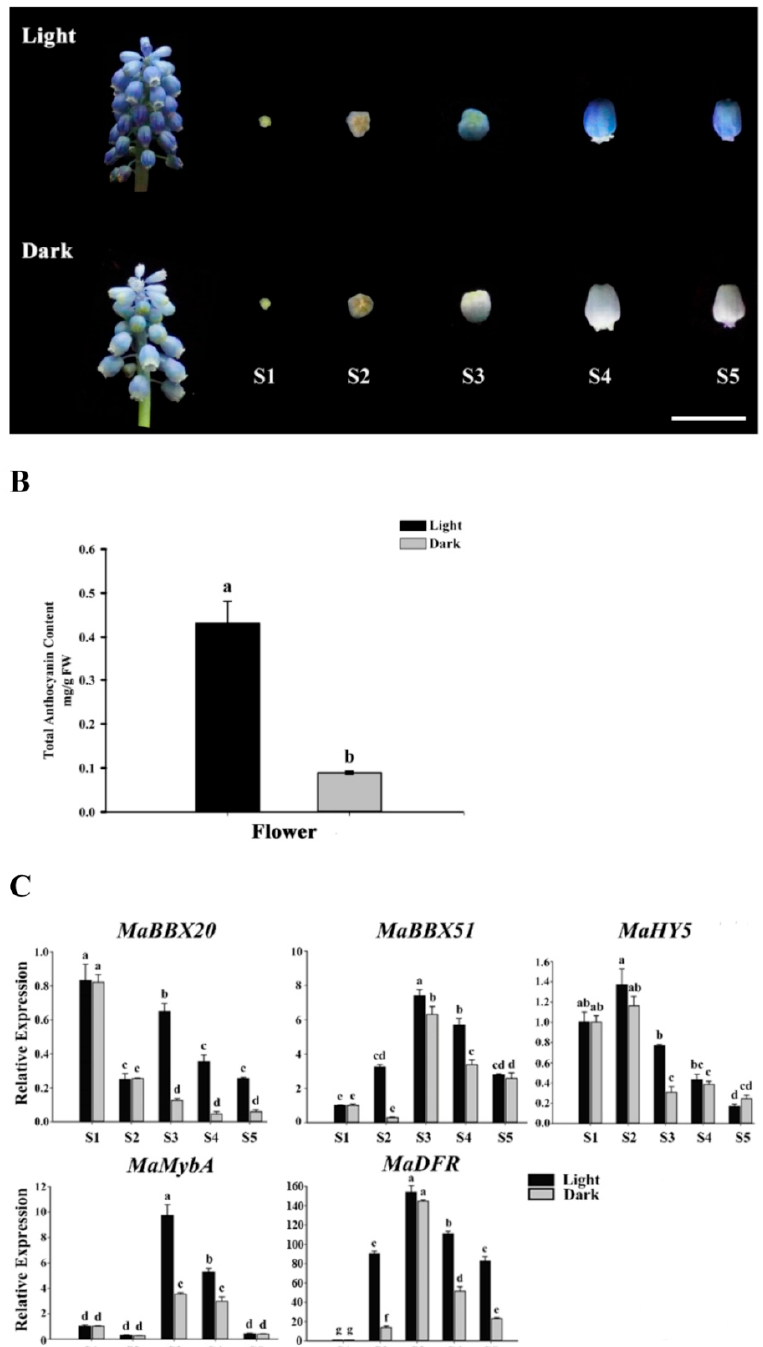
Figure 4. Flower anthocyanin levels and expression patterns of MaBBX20 and MaBBX51 under shade treatment in M. aucheri ‘Dark Eyes’. ( A ) Shade treatment of inflorescence blocked anthocyanin accumulation. Scale bar: 1 cm. ( B ) Shade treatment reduced the total anthocyanin content of inflorescence. FW, fresh weight. ( C ) qPCR analysis of MaBBX20 , MaBBX51 , MaHY5 , MaMybA , and MaDFR expression during flower development under light and shade conditions. MaActin was used as the reference gene. Data are presented as the mean ± SD. Different letters above the bars indicate significantly different values calculated using one-way ANOVA followed by LSD analysis ( p < 0.05).